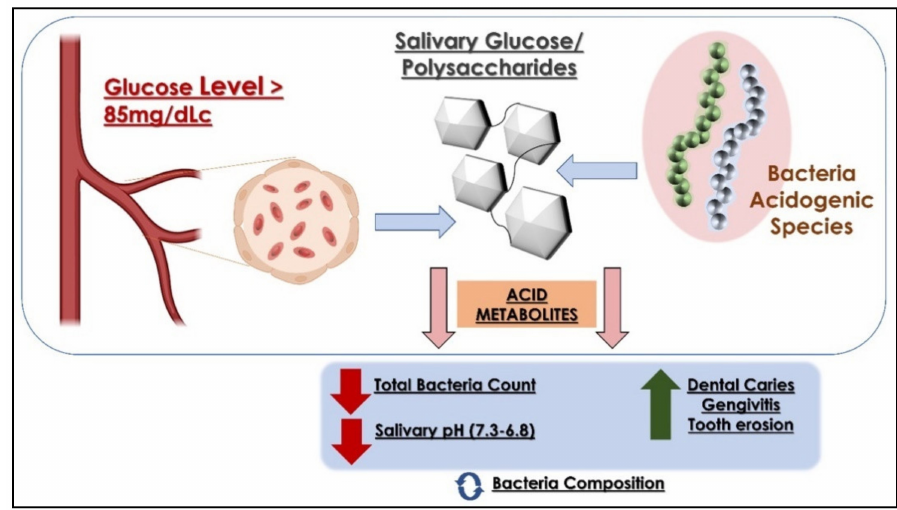
Figure 2. The proposed hypothesis to explain changes at the level of the OM with a high level of glucose in